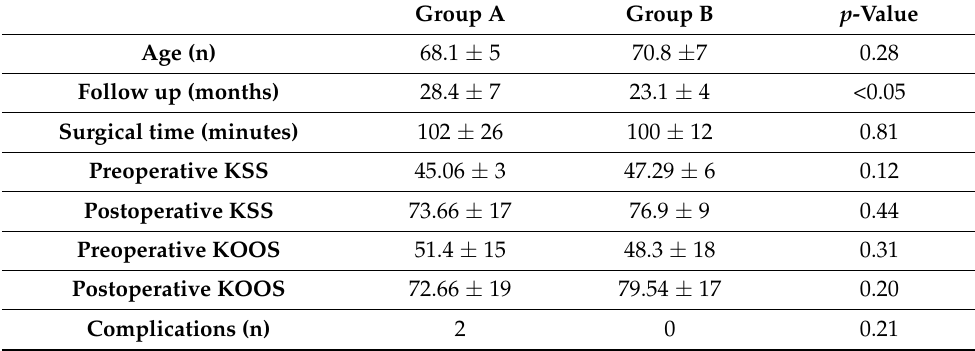
Table 1. Demographic and clinical information.